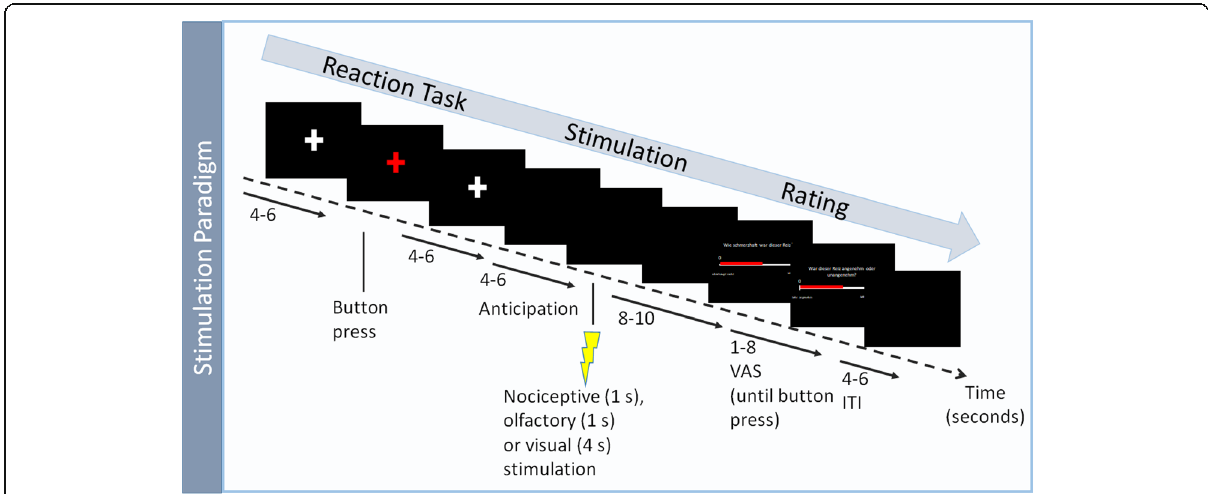
Fig. 2 Single trial of stimulation paradigm. Each trial started with a short reaction task, followed by an anticipation phase of jittered length and stimulation with one of the 4 stimuli: 3 gaseous (ammonia, rose odour and air) or a visual stimulus (rotating checkerboard). At the end of each trial subjects rated stimulus painfulness/intensity and pleasantness on two visual analogue scales (VAS). Abbreviations: ITI, Inter-trial